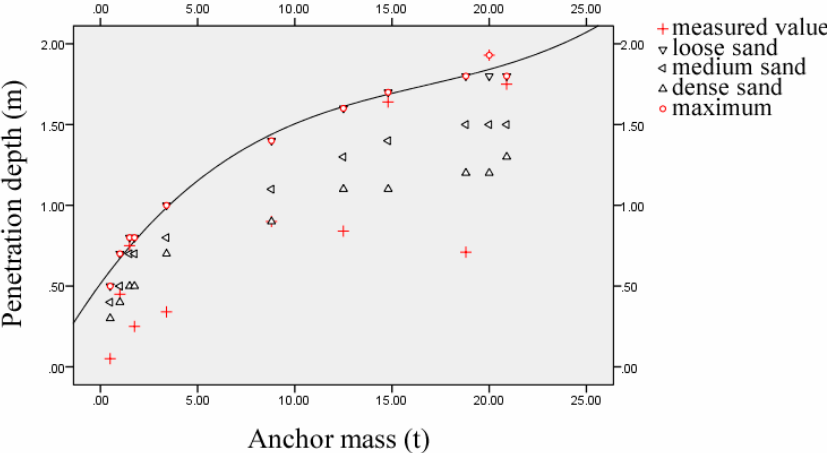
Figure 10. Scatterplot and regression curve of clay substrate penetration data (the measured values are from).